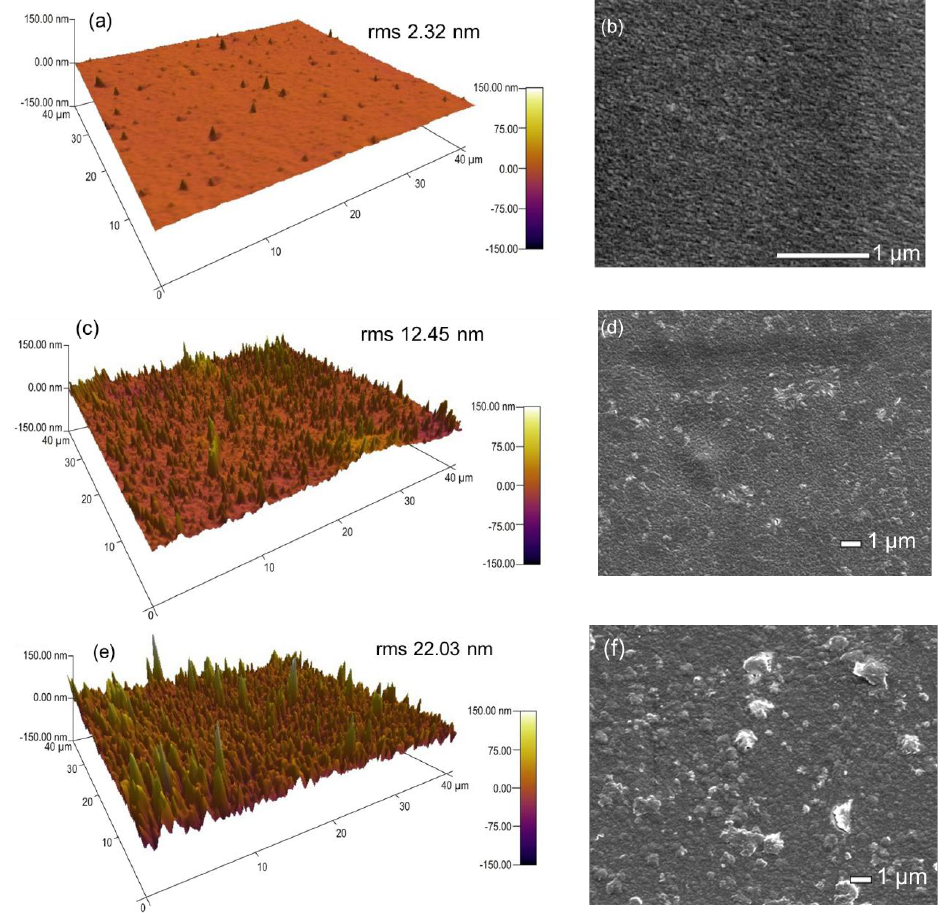
Figure 1. Atomic Force Microscopy (AFM) and SEM analysis of aluminum-doped zinc oxide (AZO) layers deposited on ( a , b ) AZO / glass ( c , d ) AZO / polyethylene terephthalate (PET) (before bending test) and ( e , f ) AZO / PET (after bending 1000 times, discussed in 3.1.4.).